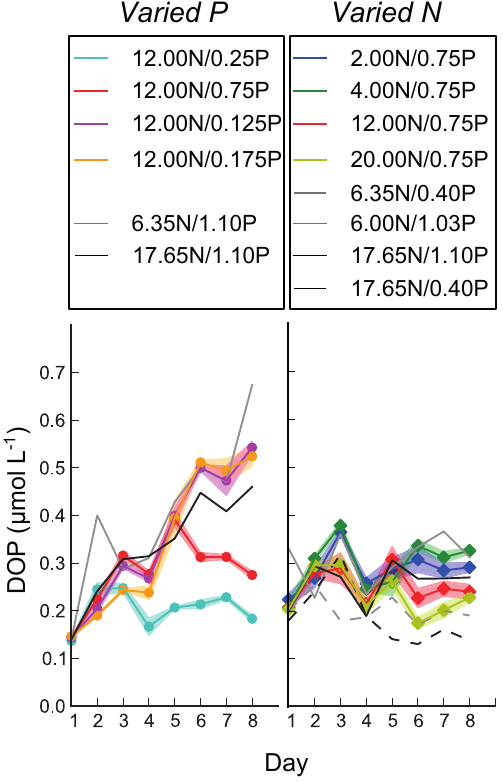
Figure 4. PON/POP stoichiometry during (a) the exponential growth phase and (b) the stationary growth phase of the experi- ment. The gray line visualizes the Redfield Ratio. The color code, symbols and lines are the same as in Fig. 3.